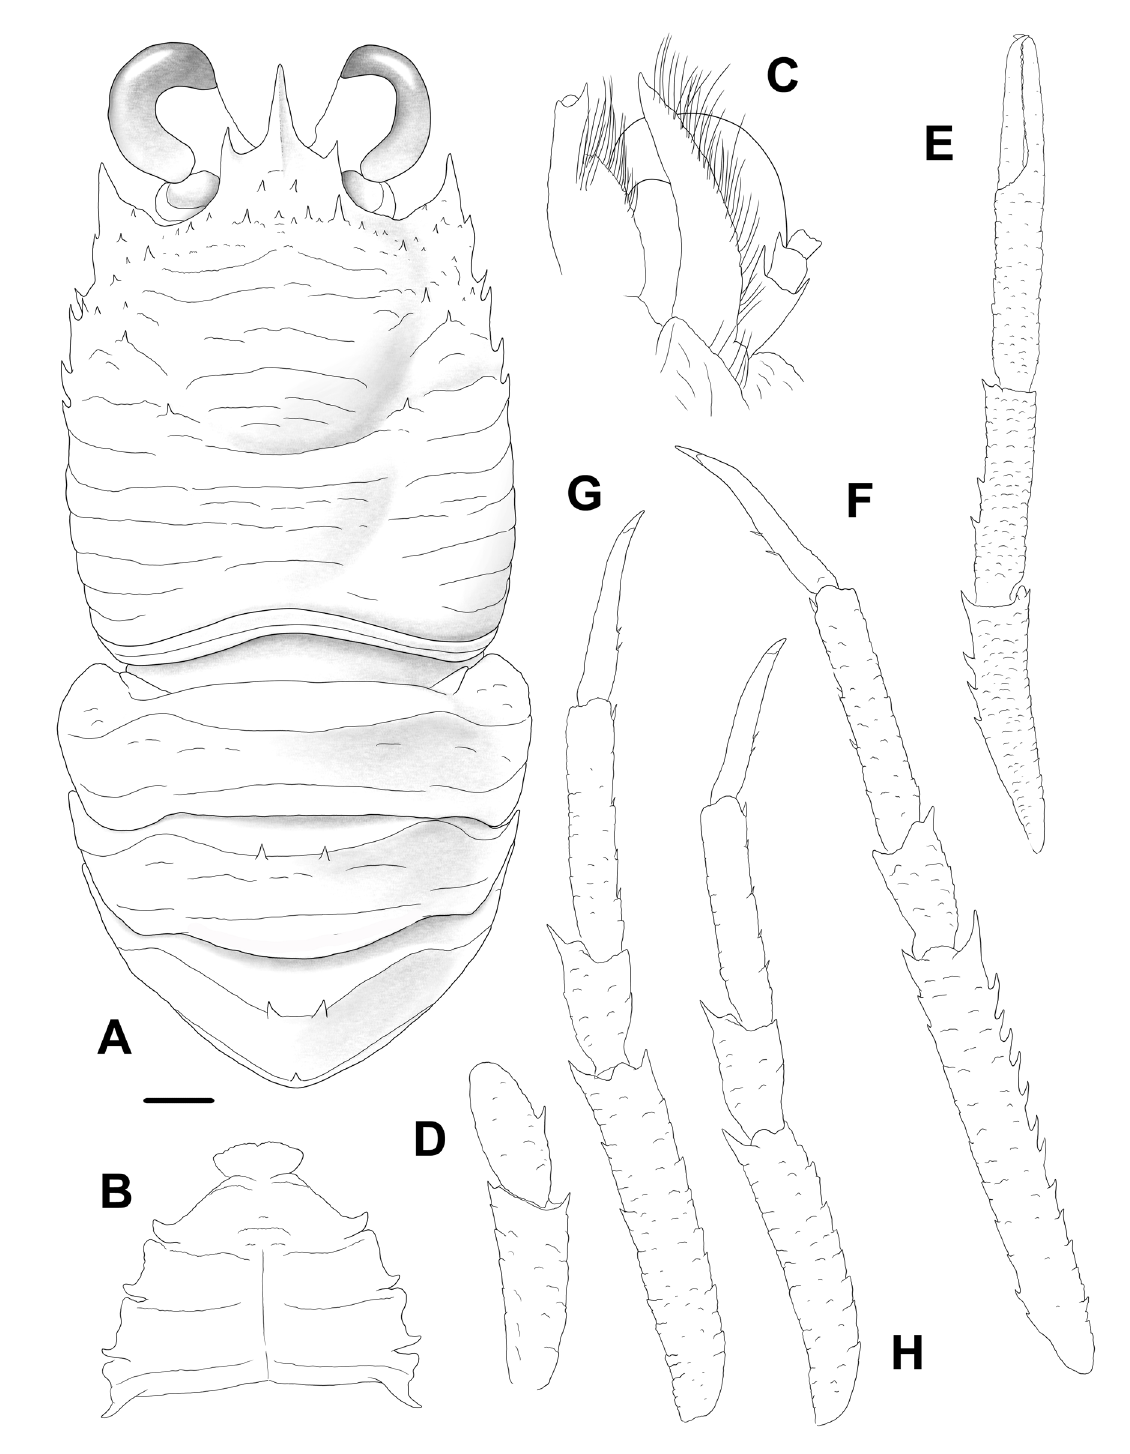
Fig. 3. Torbenella crateris sp. nov., holotype, ov. ♀, CL = 7.2 mm (MNHN-IU-2013-1858), New Caledonia. A . Carapace and abdomen, dorsal view. B . Sternal plastron. C . Cephalic region, showing antennular and antennal peduncles, ventral view. D . Right Mxp3, lateral view. E . Right P1, dorsal view. F . Left P2, lateral view. G . Right P3, lateral view. H . Right P4, lateral view. Scale bar: A–B, F–H = 1.0 mm; C–D = 0.5 mm; E = 2